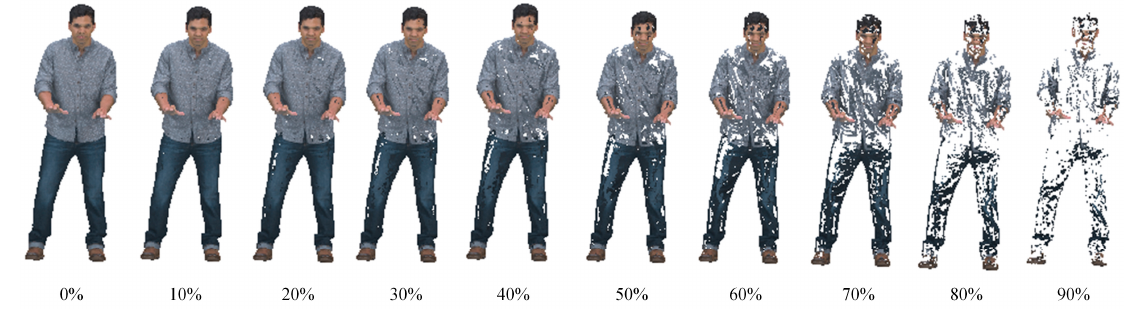
Figure 6. High-curvature points under various low-curvature determination ratios.